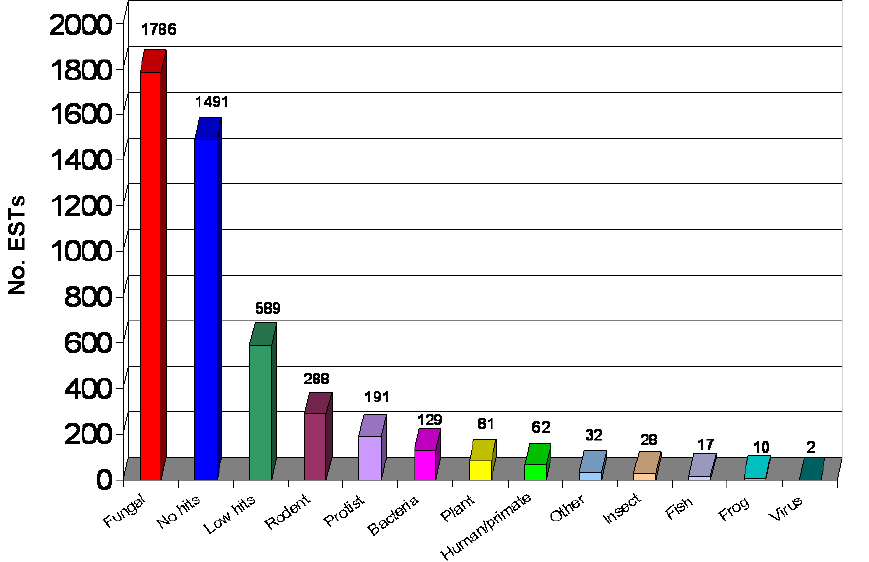
Figure 2. Binning of P.cariniiEST gene homologs by general organism groups. After trimming the raw EST reads for poor quality sequence (qTrim), the ESTs were analyzed for similarities to gene products of other organisms using BLASTx. Significance was set at E # 10 2 6